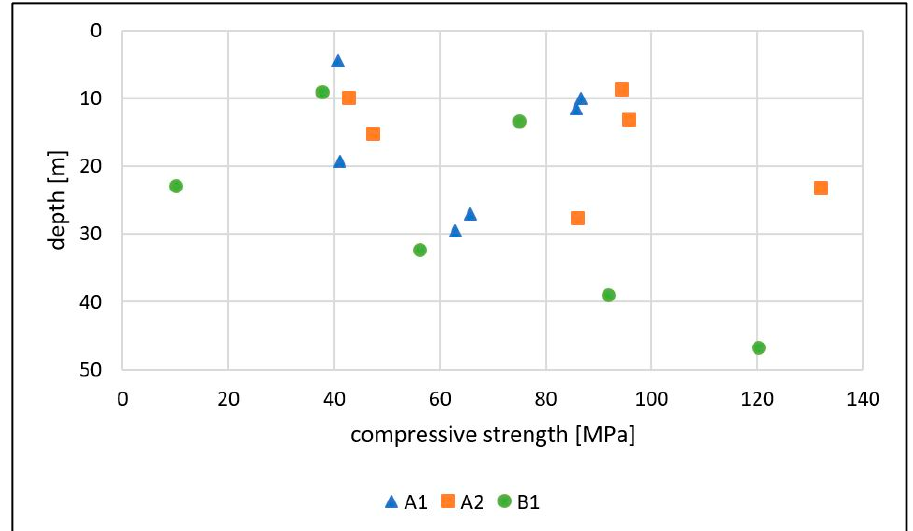
Figure 8. Results of the uniaxial compressive strength tests plotted vs. the sampling